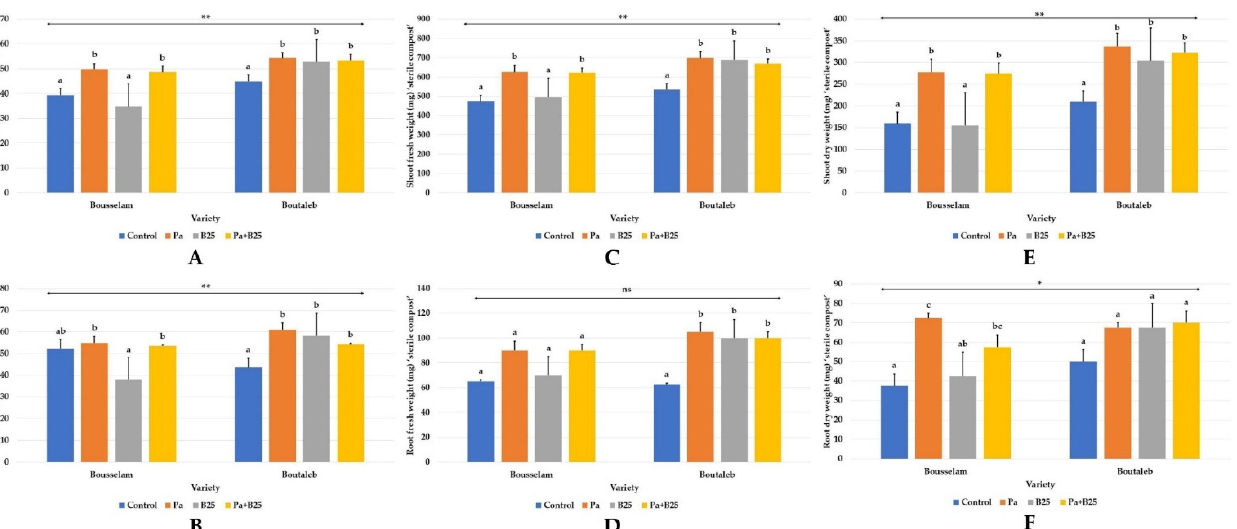
Figure 2. Effect of bacterial inoculation on in vitro wheat seedling germination. Top: Bousselam variety. Bottom: Boutaleb variety.